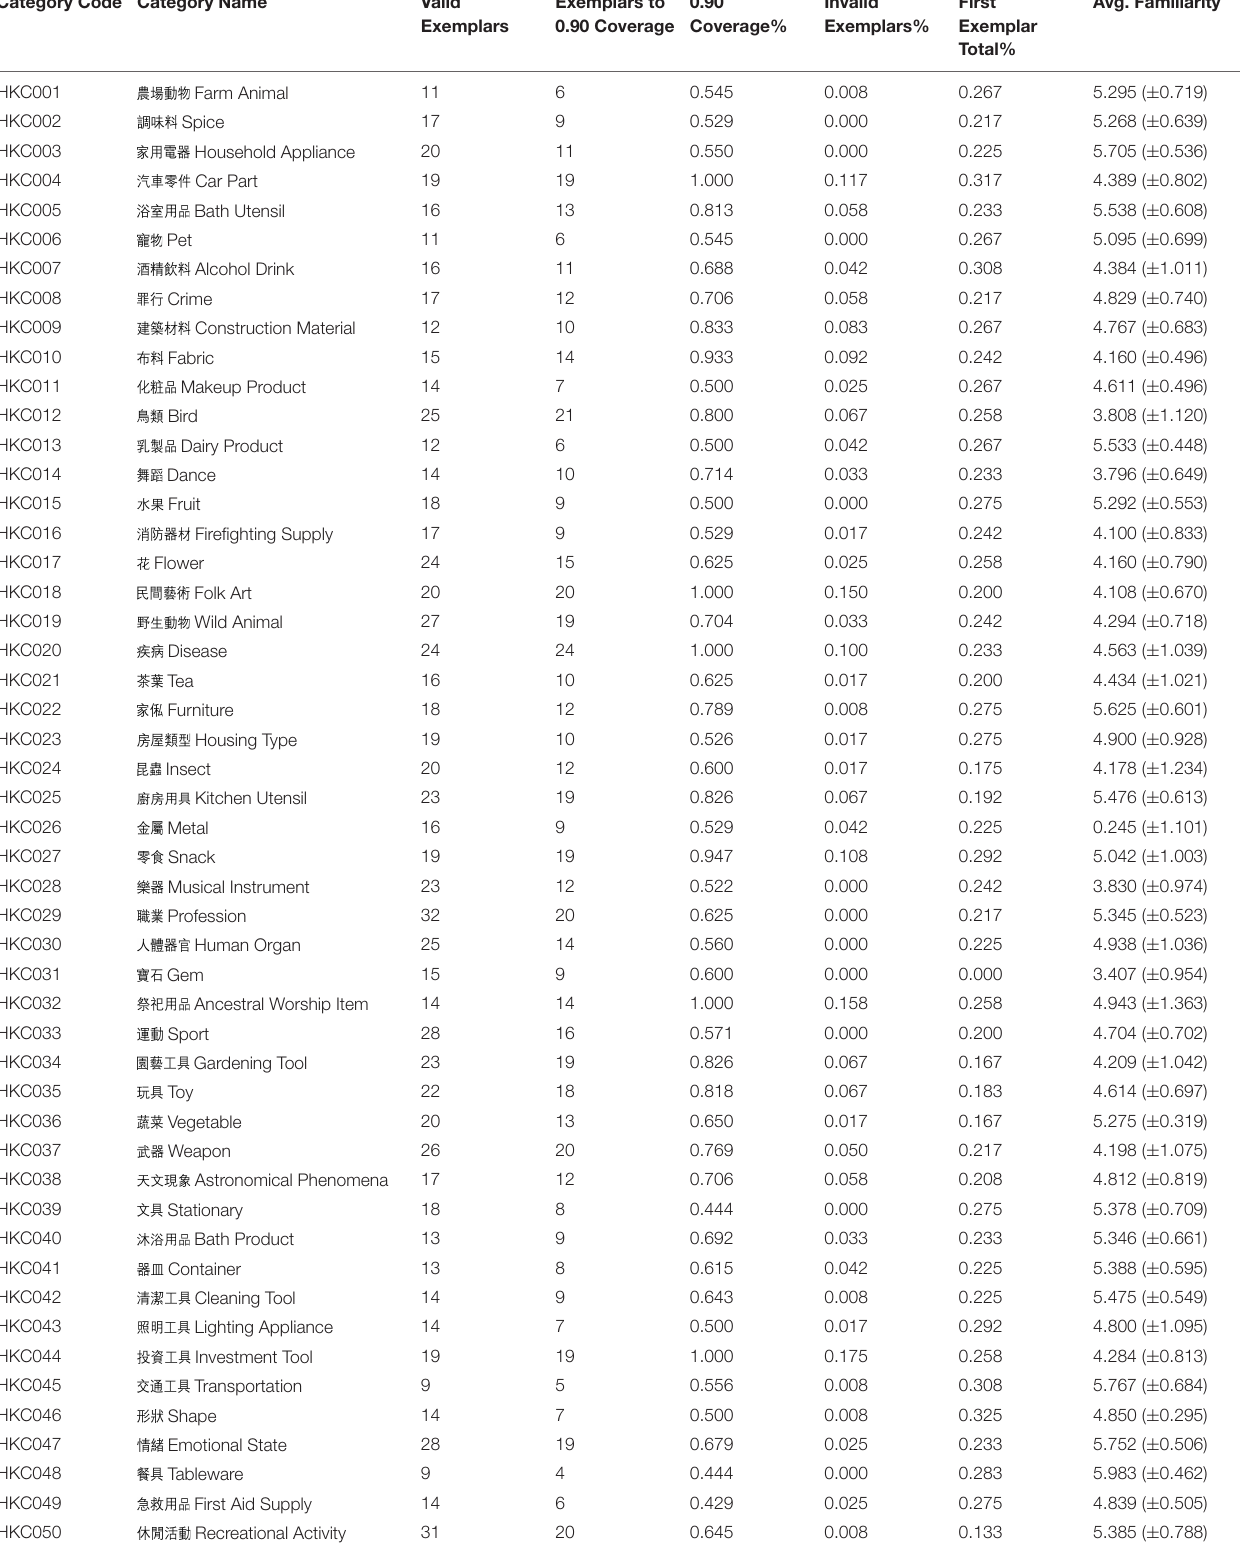
TABLE 4 | Compiled statistics for all